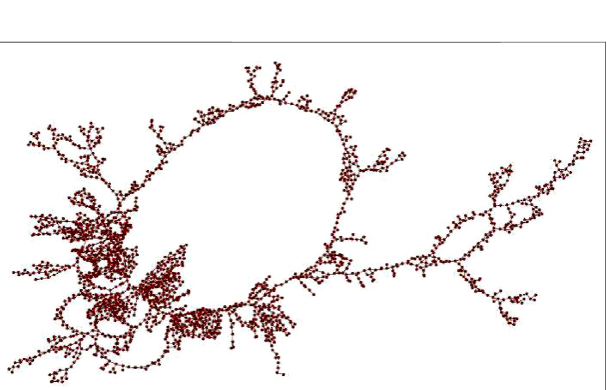
FIGURE 7 | Pre-earthquake road network